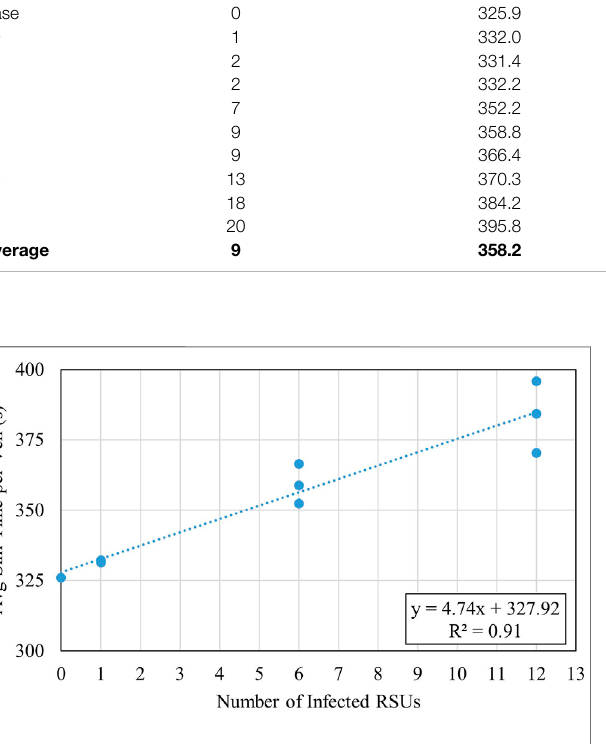
FIGURE 4 | MITM Infected RSUs vs Travel Time.